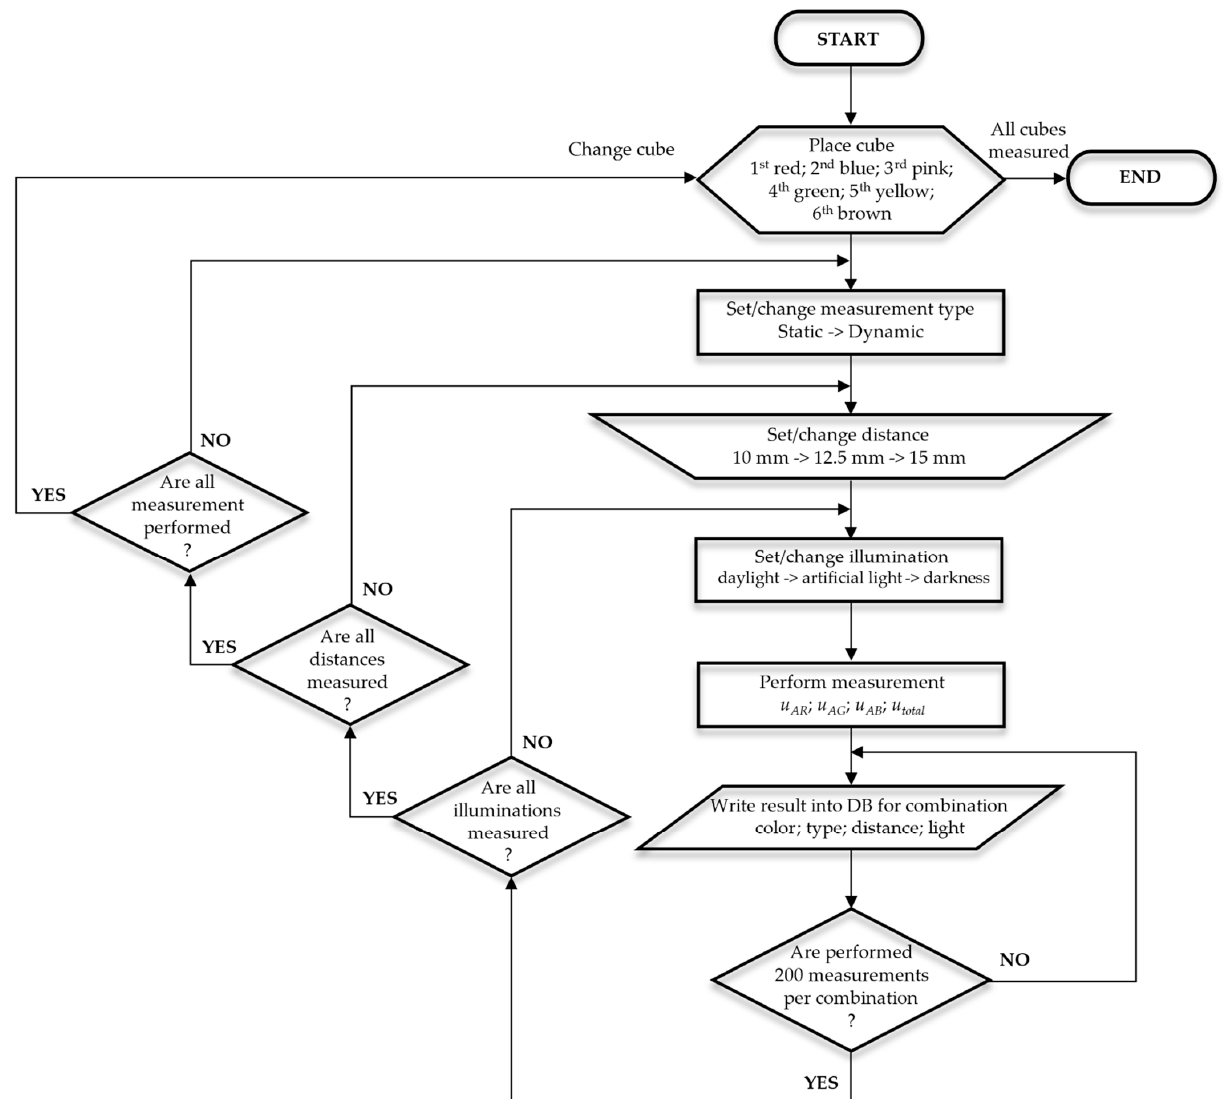
Figure 2. Measurement process workflow diagram.